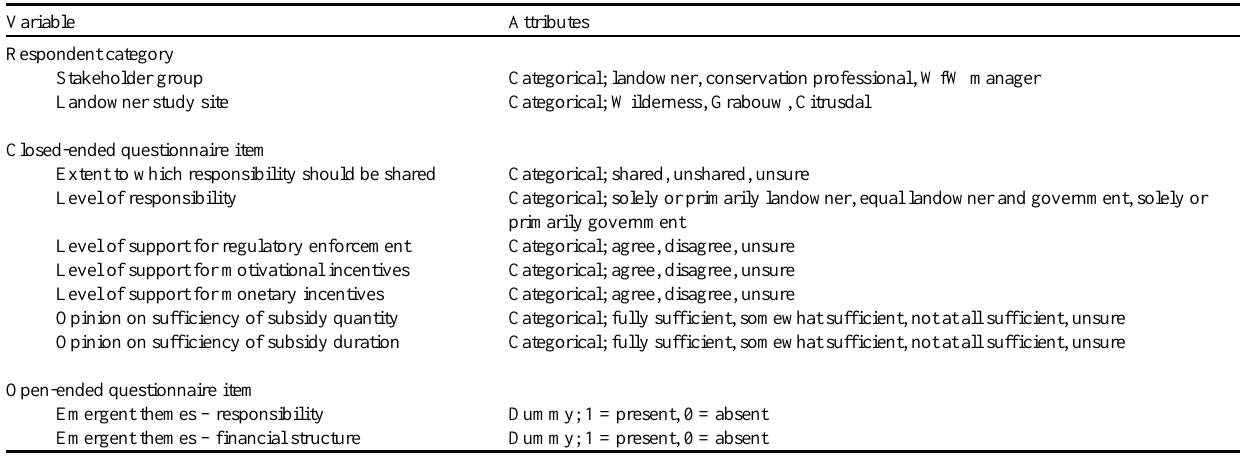
Table 3 . Variables used in analysis of stakeholder perceptions regarding WfW’s proposed ecosystem service (ES) approach to clearing IAPs on private land, Western